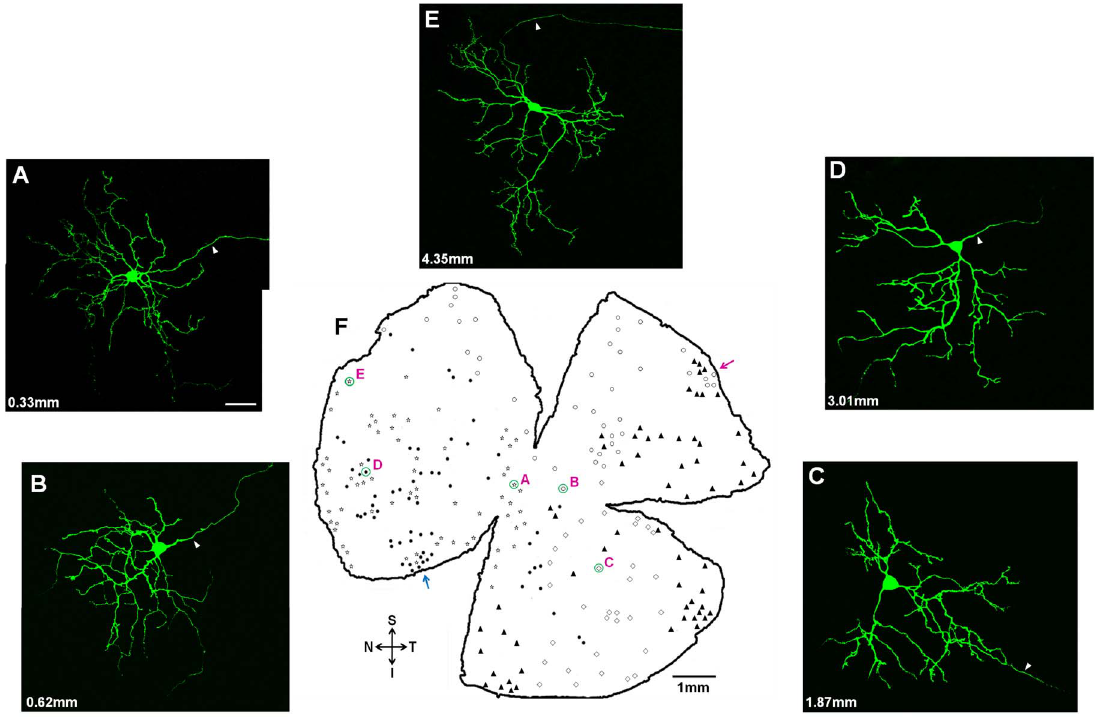
Figure 5. Dendritic morphology and distribution pattern of caudal periaqueductal gray (cPAG)-projecting retinal ganglion cells (RGCs). (A–E) Morphology of intracellularly injected cPAG-projecting RGCs located at different parts of the retina. Arrowheads point to axons. The distances from these cells to the optic disk are: 0.33 mm in (A), 0.62 mm in (B), 1.87 mm in (C), 3.01 mm in (D) and 4.35 mm in (E). (F) Schematic N representation of the distribution pattern of Cholera toxin B subunit (CTB) retrogradely labeled cPAG-projecting RGCs from 5 animals. Coordinates of : Lambda: 2 3.2 mm, midline: left 1.05 mm, depth: 2.73 mm; q : Lambda: 2 3.208 mm, midline: left 0.92 mm, depth: needle tips in 5 animals: 2.69 mm; m : Lambda: 2 3.204 mm, midline: left 1.08 mm, depth: 2.72 mm; e : Lambda: 2 3.212 mm, midline: left 1.08 mm, depth: 2.64 mm; # : Lambda: 2 3.192 mm, midline: left 1.05 mm, depth: 2.82 mm; Green circled cells of A–E are correspondent to the Figure 5A–5E, respectively. One peripheral area (magenta arrow) and two central areas (blue arrow and cell D) have similar local densities. S: superior; I: inferior; N: nasal; T: temporal. Scale bars: 20 m m in A (applies to B–E); 1 mm in F.